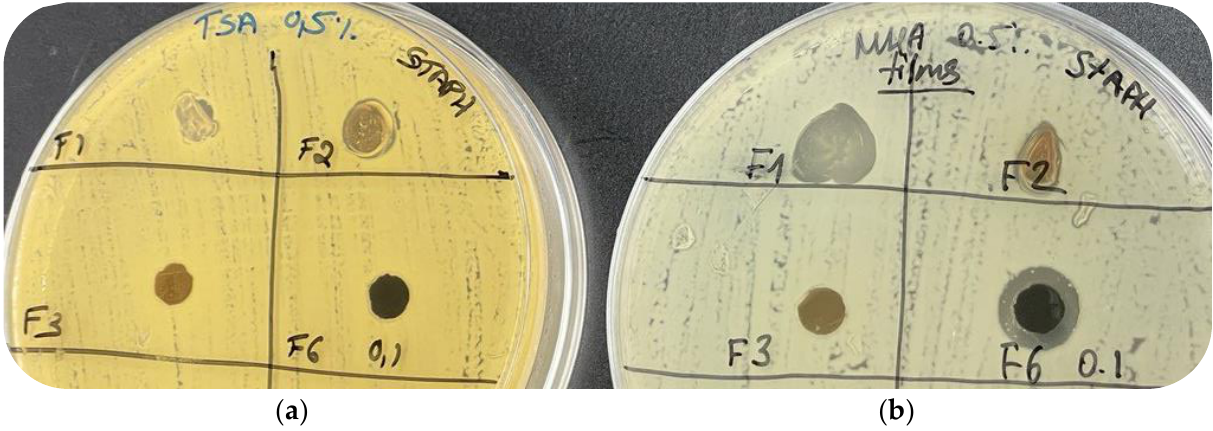
Figure 11. Results of the optimization of the disk diffusion test conditions on: ( a ) tryptic soy agar 0.5% (TSA) and ( b ) Mueller – Hinton agar 0.5% (MHA).